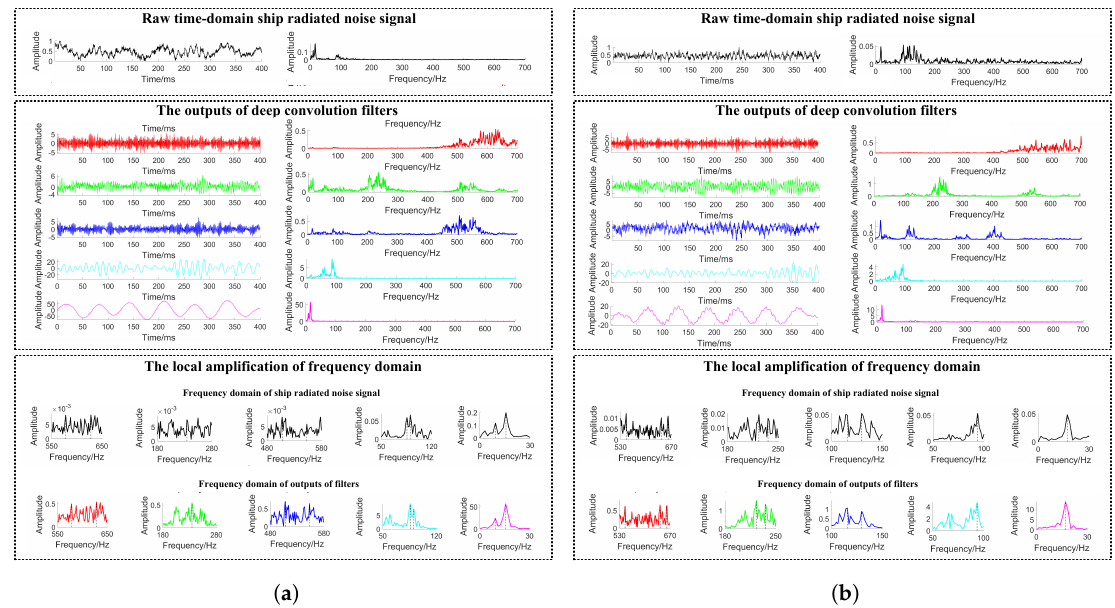
Figure 3. Visualization of the output of each filter. ( a ) Testing sample of Cargo class; ( b ) Testing sample of Passenger ship